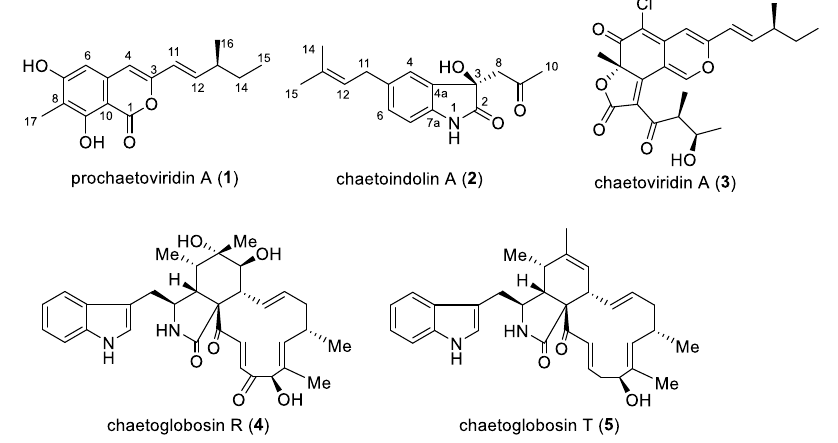
Figure 1. Structures of compounds 1 – 5 . Table 1. NMR spectroscopic data of 1 in CDCl 3 .